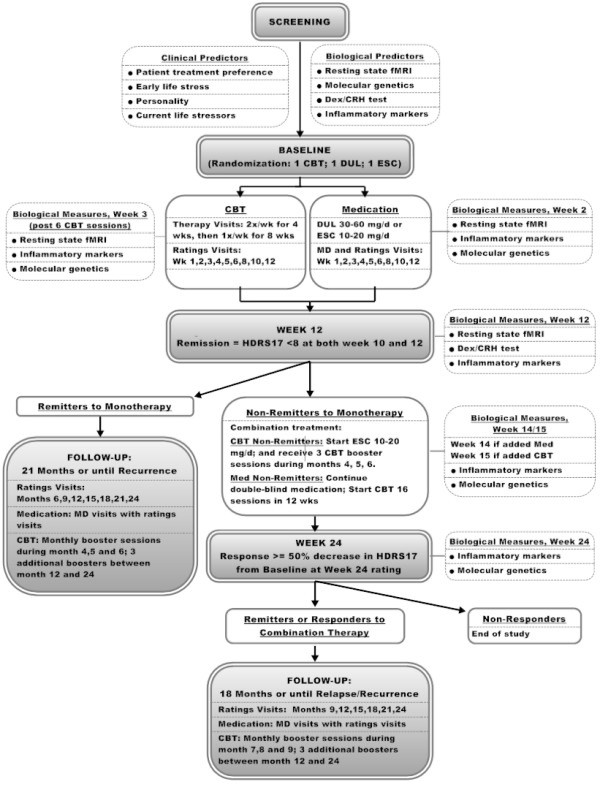
PReDICT study design.